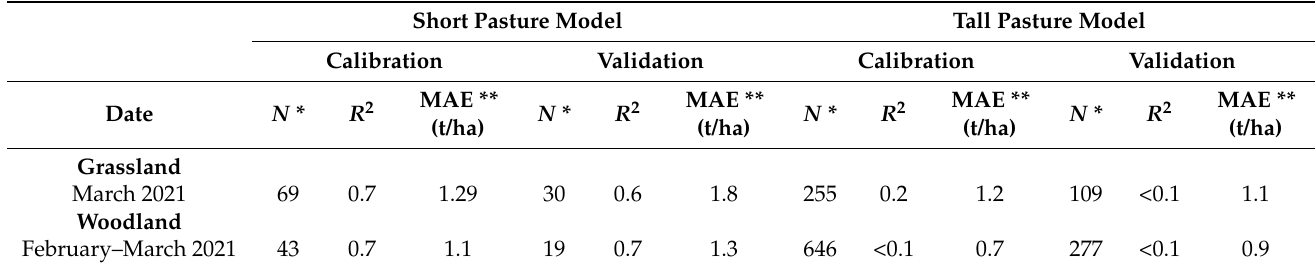
Table 5. Planet satellite pasture yield modelling summary.